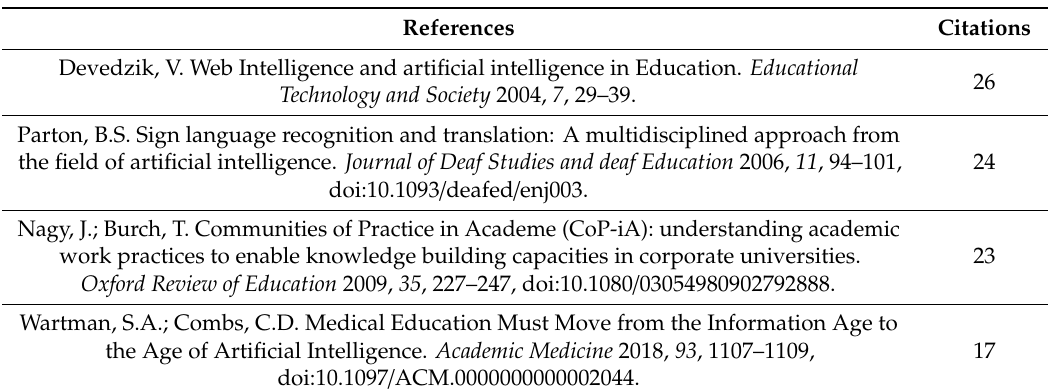
Table 9. Most cited articles.